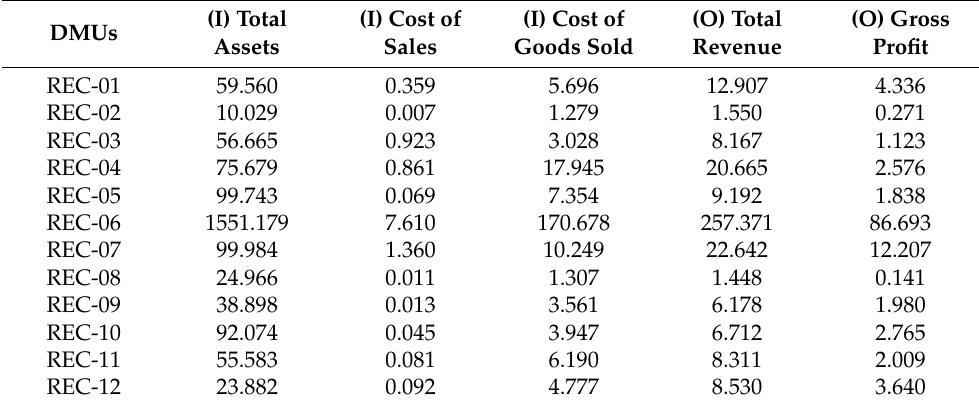
Table A1. The historical data of the year 2015, (unit: million USD).